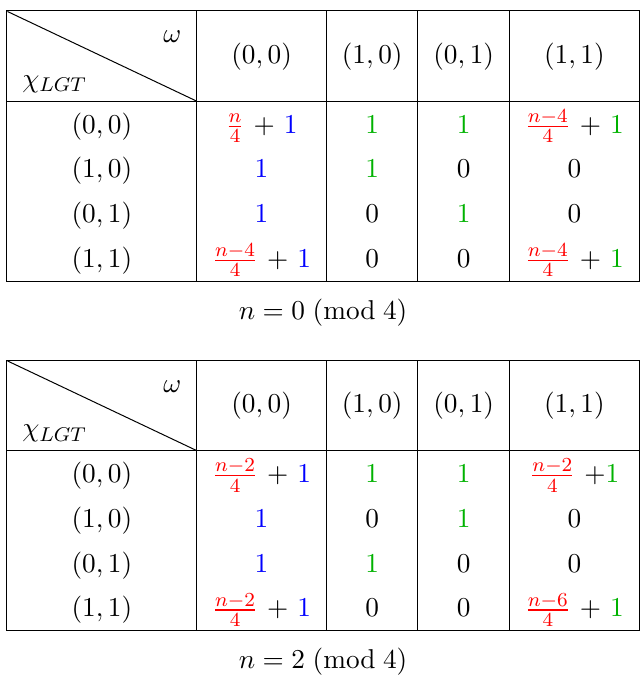
Table 6 . Counting of (cid:13)at PSL 0 (2 ; C ) connections on S 3 = (cid:0) D and (cid:31) LGT , for n = 0 (mod 4) on the top and n = 2 (mod 4) below. Here we show the contribution from the trivial connection in blue, the other reducible connections in green, and the irreducible connections in